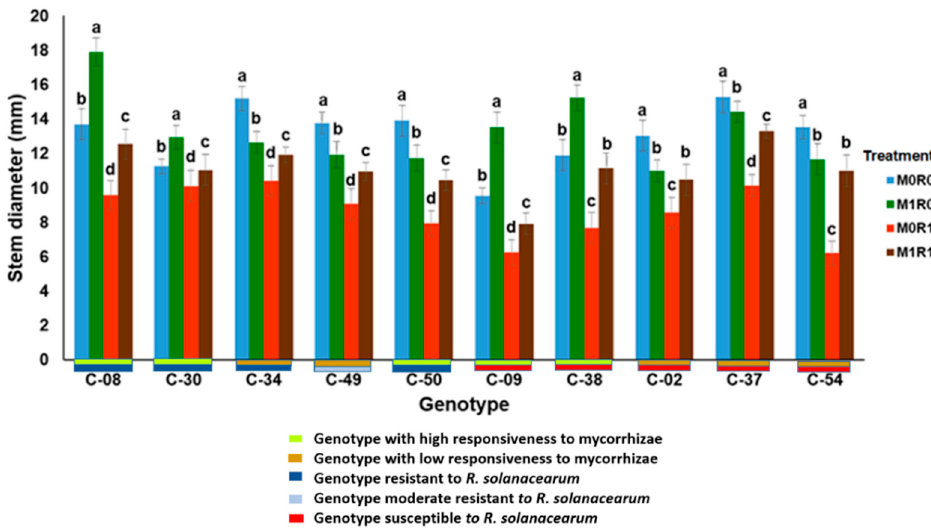
Figure 8. Stem diameter of ten genotypes tropical chili pepper as a phenotypic response to the treatments. Bars represent mean ± standard deviation. The same lowercase letters indicate no significant difference in mean values between treatments in each genotype according to the Scott-Knott test at a significance level of 0.95.